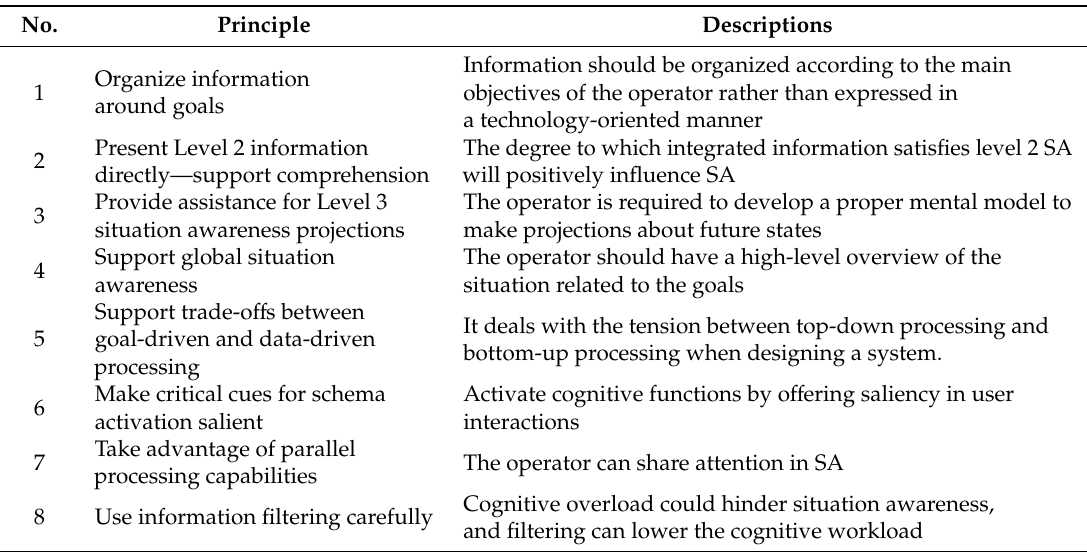
Table 1. SA principles suggested by Endsley [3].